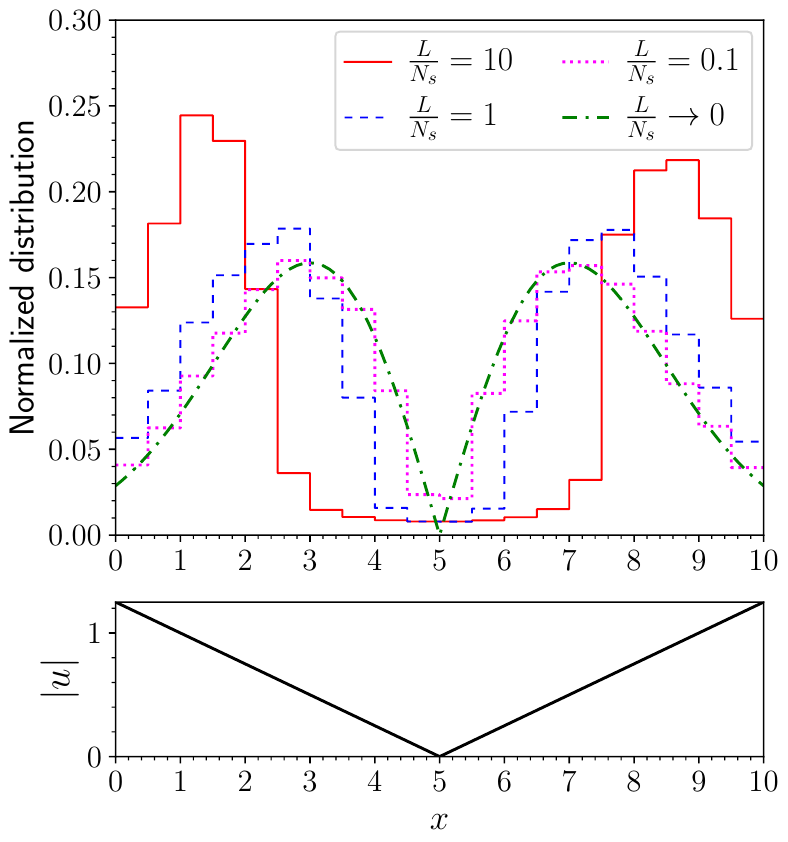
Figure 4: OASIS-trained distributions for several different choices of L / N training, as indicated by the legend. The green dot-dashed line shows the theoretical optimal sampling distribution in the large N line in Figure 1). The bottom panel shows the absolute value of the per-event score | u | as a function of x